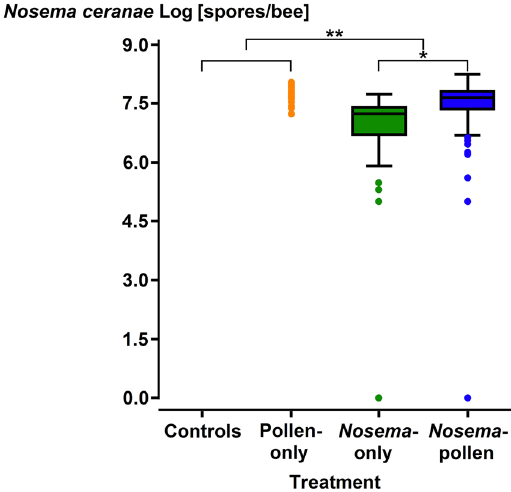
Figure 2. N. ceranae spore loads of individual honey bee workers in the four treatment groups (Controls, Pollen-only [orange], Nosema -only [green], Nosema -pollen [blue]). Medians, ranges, confidence intervals and outliers ( = dots) are shown at a log scale. Significant differences were found between the groups Nosema -pollen and Nosema -only, as well as between the two Nosema groups and the Controls. Please note that N = 19 bees in the Pollen-only treatment were naturally contaminated with N. ceranae . When excluding these contaminated bees from the Pollen-only group, significant differences were still found between the groups Nosema -pollen and Nosema -only ( * P = 0.025, ** P < 0.0001).